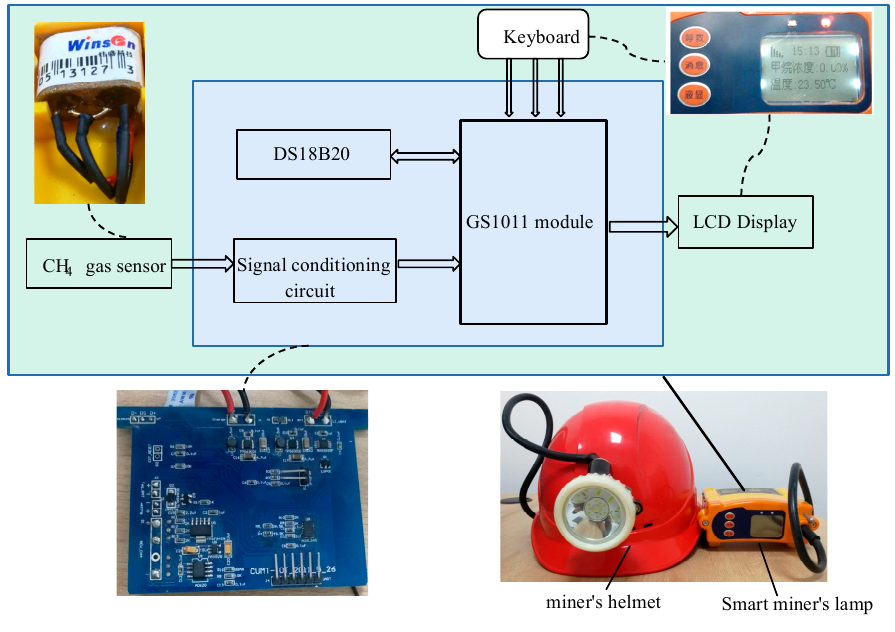
Figure 1. Smart miner’s